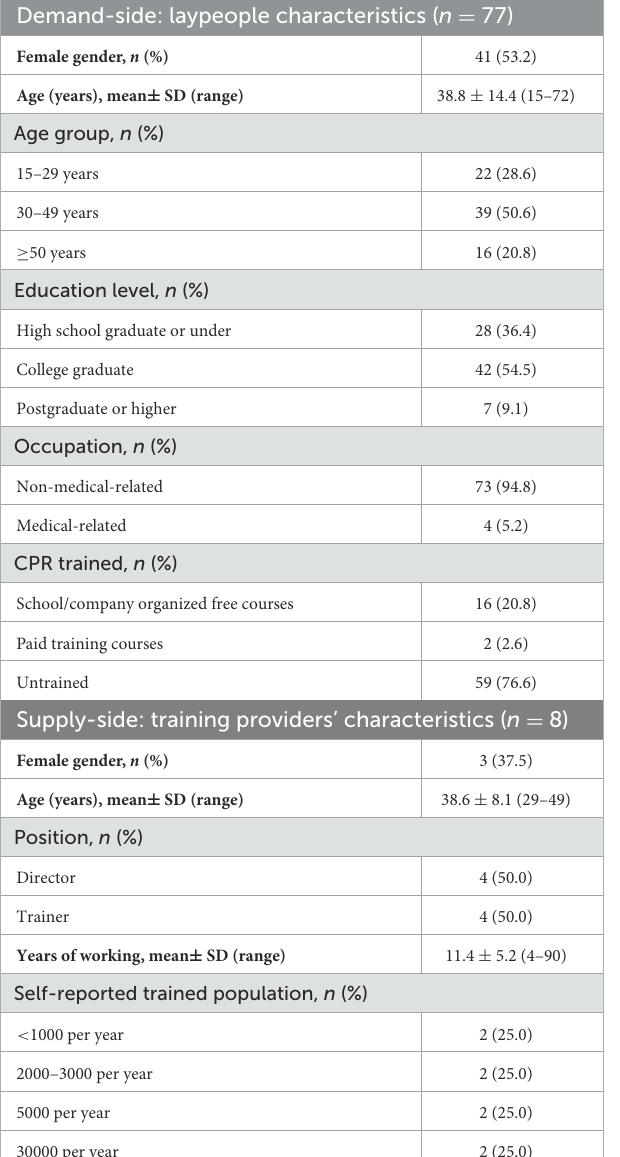
TABLE 1 Demographic characteristics of demand- and supply-side